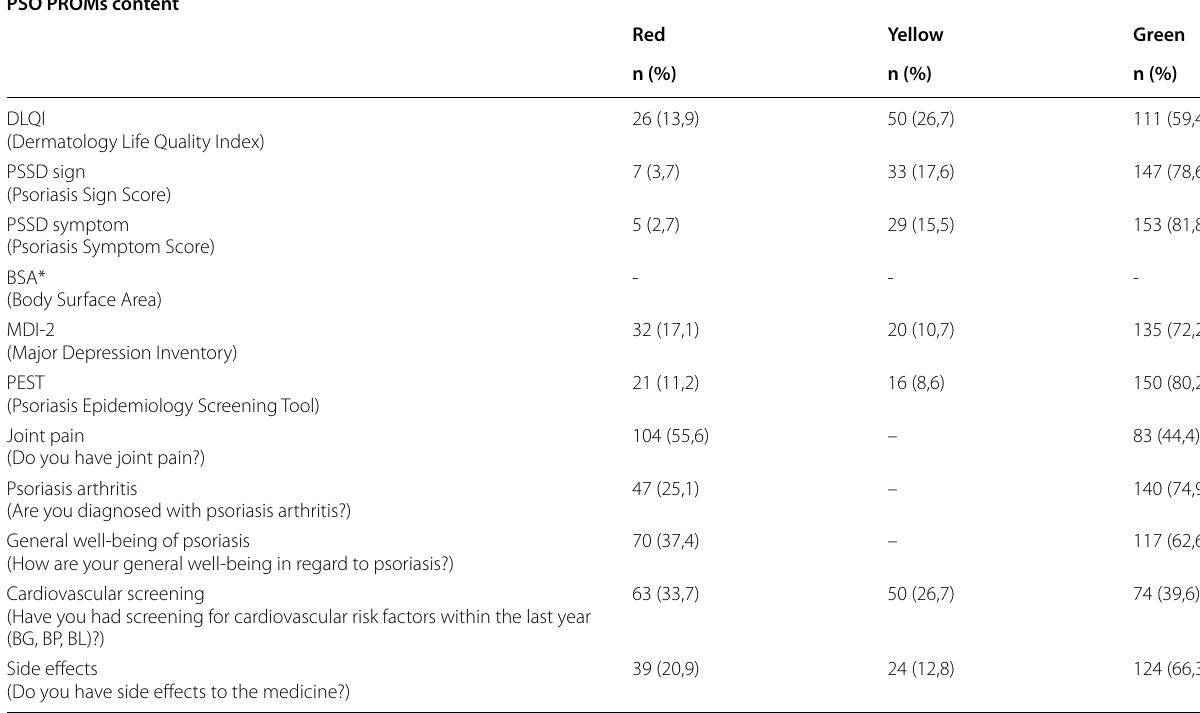
*BSA does not have a clear cut-off point. Mean score was calculated to 5,8 (range 0–61)